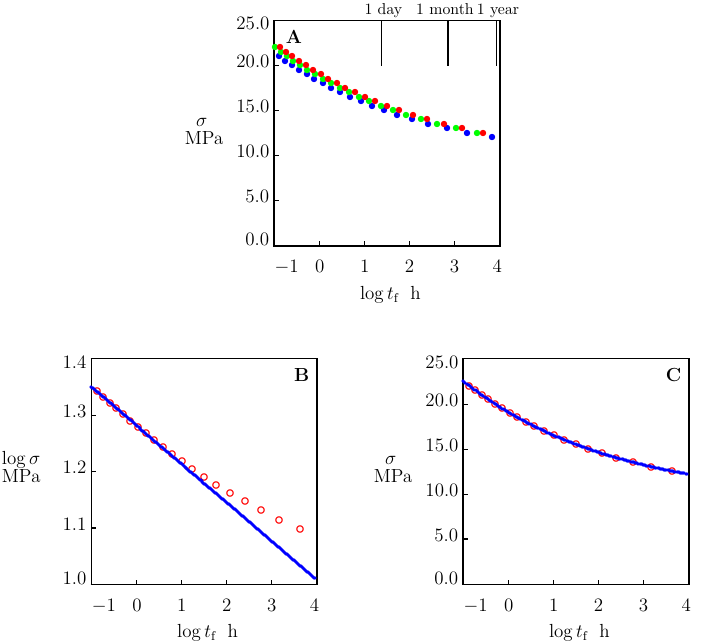
Figure 9. Tensile stress σ versus time-to-failure t f . ( A ) Circles: predictions of the model with (cid:101) cr = 0.3 Figure 9: Tensile stress σ versus time-to-failure t f . A – Circles: predictions of the model (blue), (cid:101) cr = 0.4 (green) and (cid:101) cr = 0.5 (red). ( B , C ) Circles: predictions of the model with (cid:101) cr = 0.5. Solid with (cid:15) cr = 0 . 3 (blue), (cid:15) cr = 0 . 4 (green) and (cid:15) cr = 0 . 5 (red). B, C – Circles: predictions of the lines: their approximations with ( B ) the Eyring equation and ( C ) the power-law model with (cid:15) cr = 0 . 5. Solid lines: their approximations by the Eyring equation (B) and the power-law equation (C).